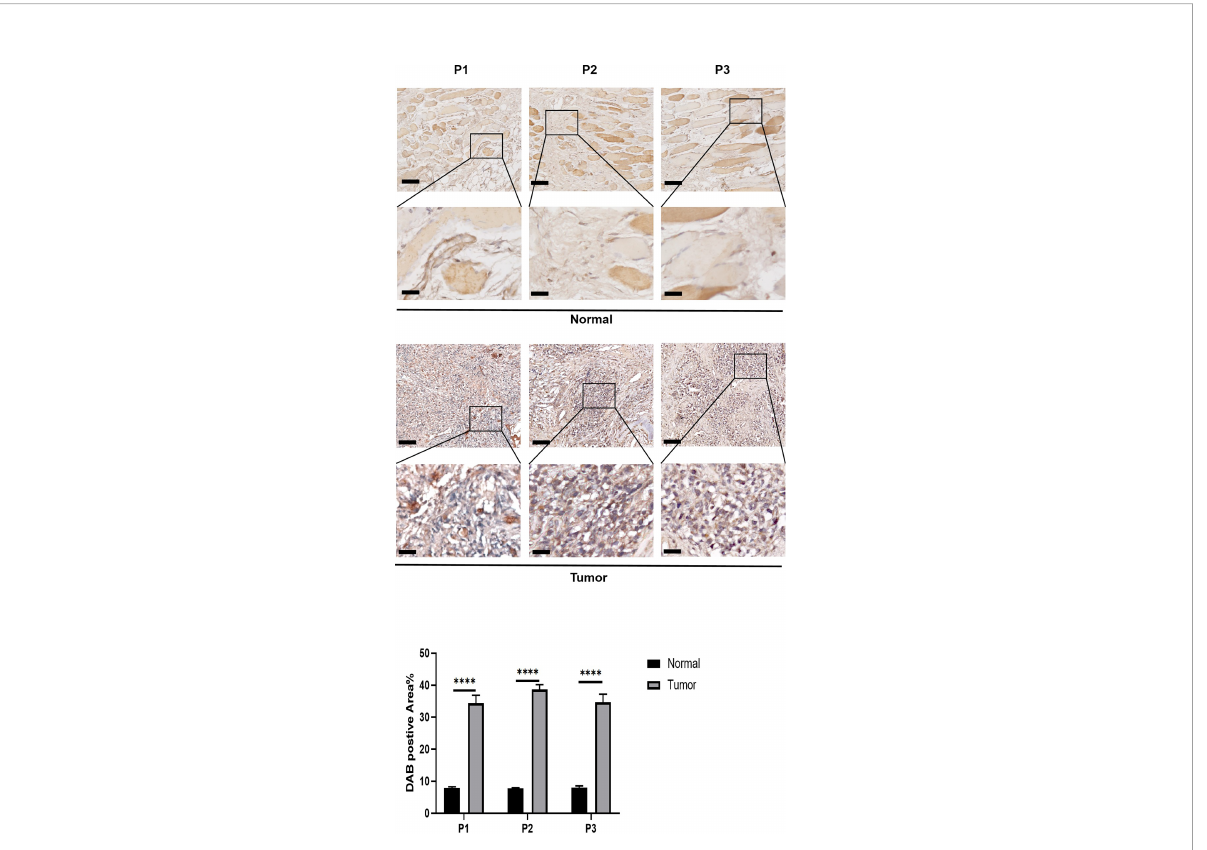
FIGURE 8 In vitro validation on PCCB. IHC results of the expression of PCCB in osteosarcoma tumor tissues and normal tissues. The upper row is 10x images of the sections, and the lower row is 40x images of the sections. Statistical analysis was based on mean ± SD. ****p <